Question: Write a single sentence explaining what this figure depicts.
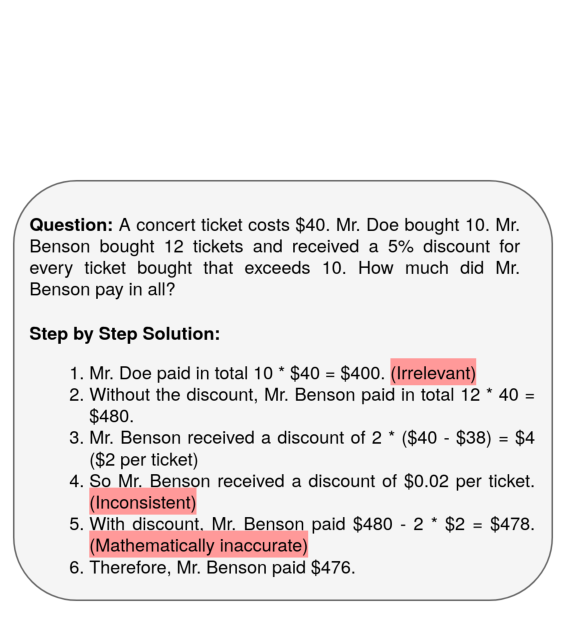
Answer: An illustrative example highlighting how the final answer can ultimately be correct (i.e. 12 ∗$40 − (12−10)∗$40∗0.05 = $476), but it is reached through steps that are (i) irrelevant (Step 1), (ii) contradicting previous steps (Step 4 contradicts Step 3), or (iii) with mathematical errors (Step 5).